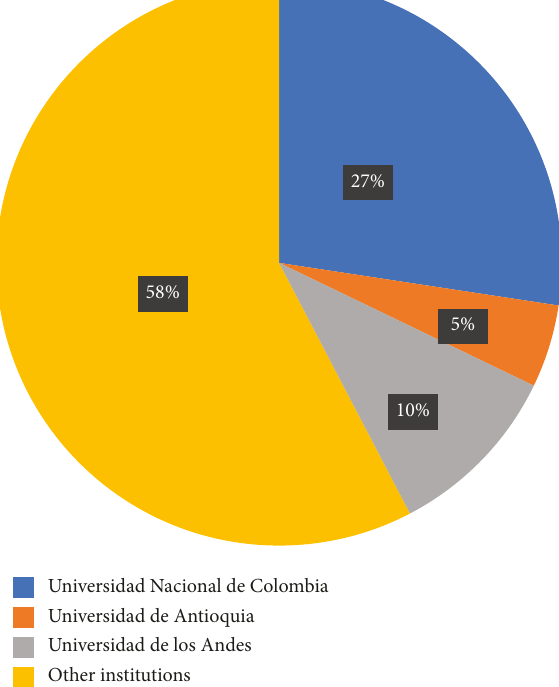
Figure 5: Percentage of relevant institutions by collaborations in universities in